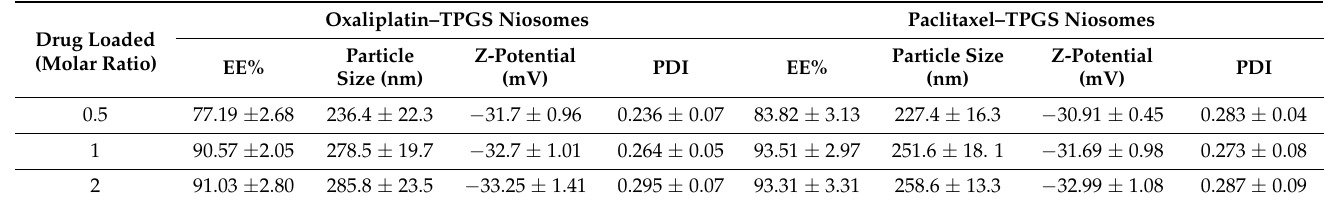
Table 3. Effect of drug concentration on EE%, particle size, and Z-potential of the prepared drug- loaded niosomes.